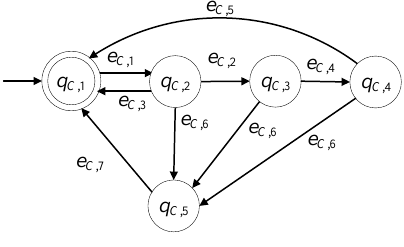
Figure 3. State diagram of G C .